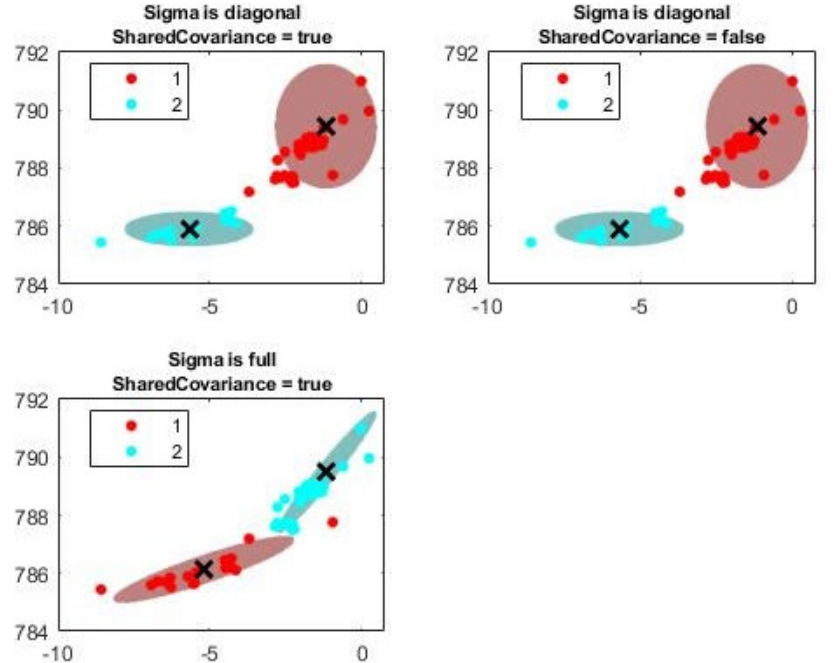
Figure 4: Gaussian mixture model with unsupervised